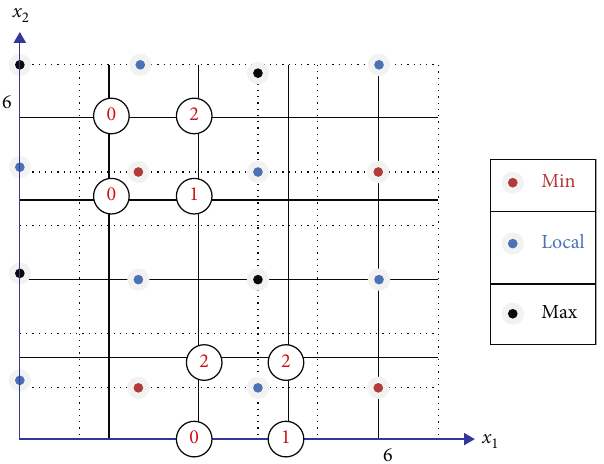
Figure 10: Second generation of f